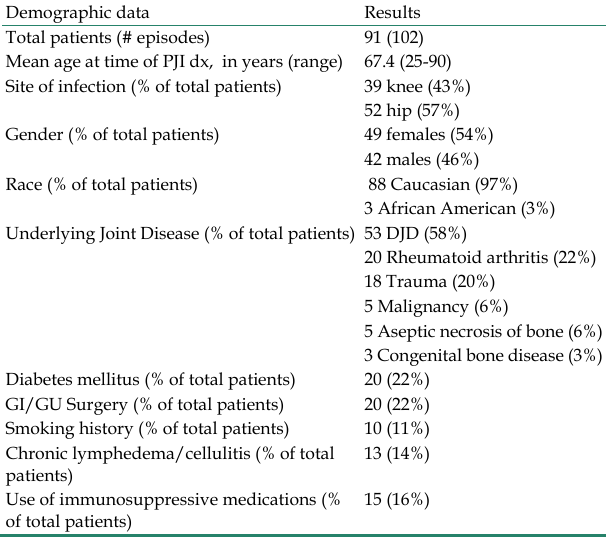
Table 1. Demographic characteristics of 91 patients presenting with Pseudomonas PJI between 1969-2012.